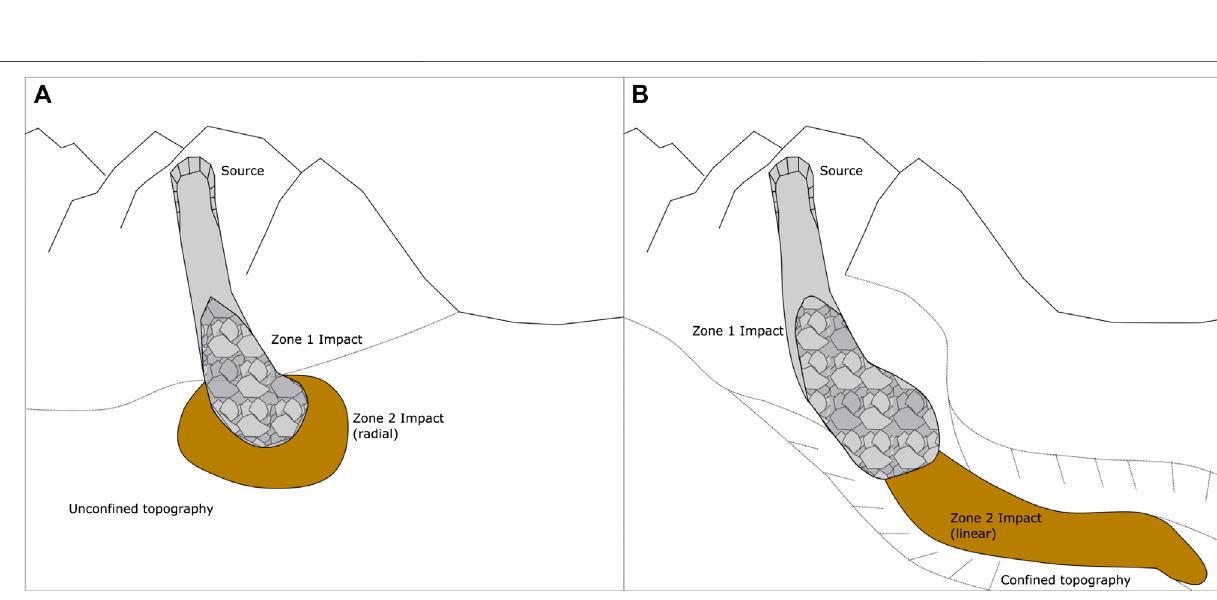
Frontiers in Earth Science |